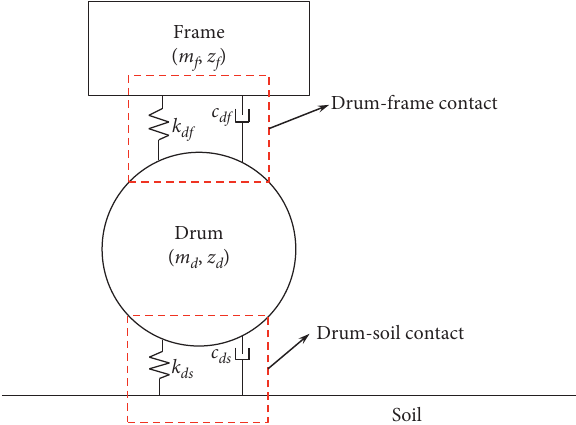
Figure 6: The 2DOF lumped parameter model of roller-soil system (Modified from Yoo